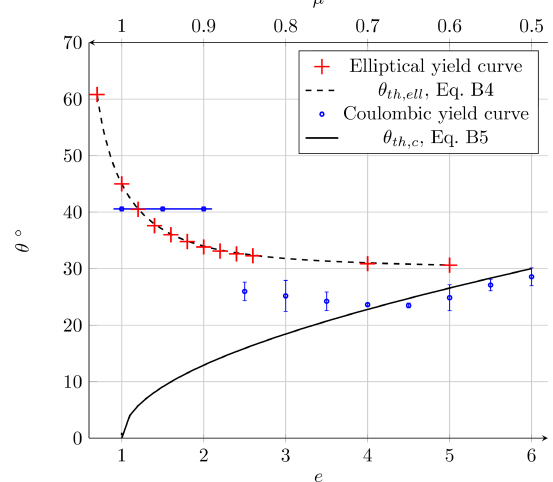
Figure 10. Fracture angles as a function of ellipse aspect ratio e with constant P (cid:63) (red, bottom scale; Sect. 3.3.1). The theoretical relationship θ th , ell = 1 Eq. B4 in the Appendix) fits the modeled angles almost